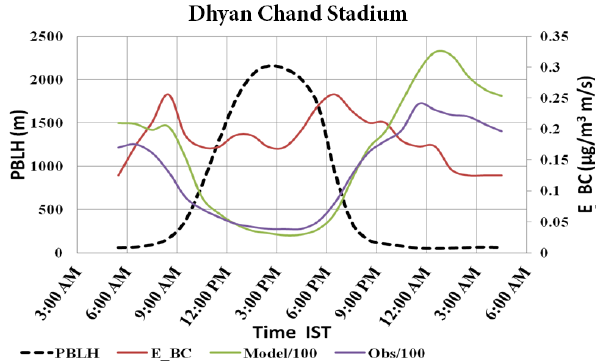
Figure 7. Mean diurnal variation in boundary layer height, emis- sions and BC concentrations from model and observations at the Dhyan Chand Stadium site.